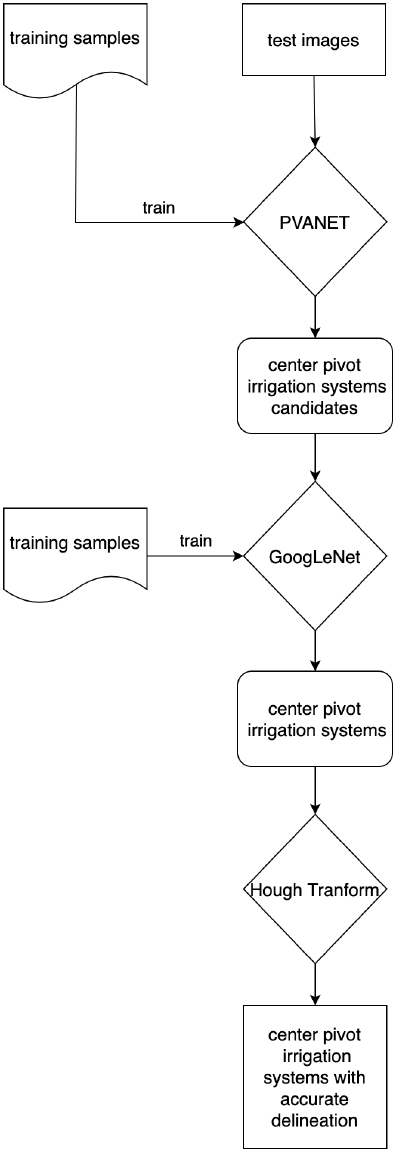
Figure 2. Flowchart of the proposed